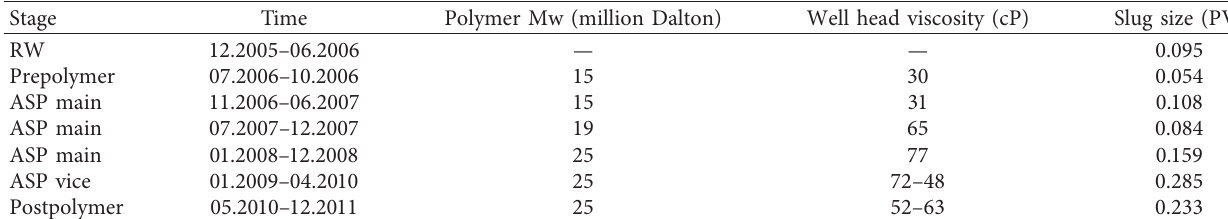
Table 17: SASP time table.